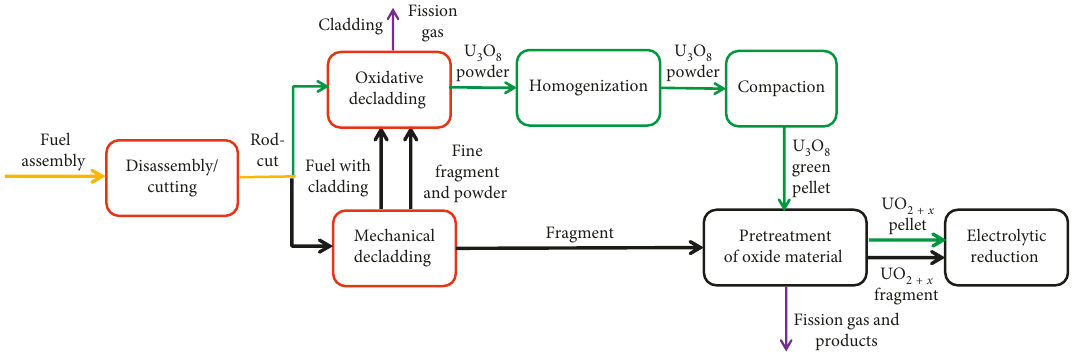
Figure 1: Entire head-end process.